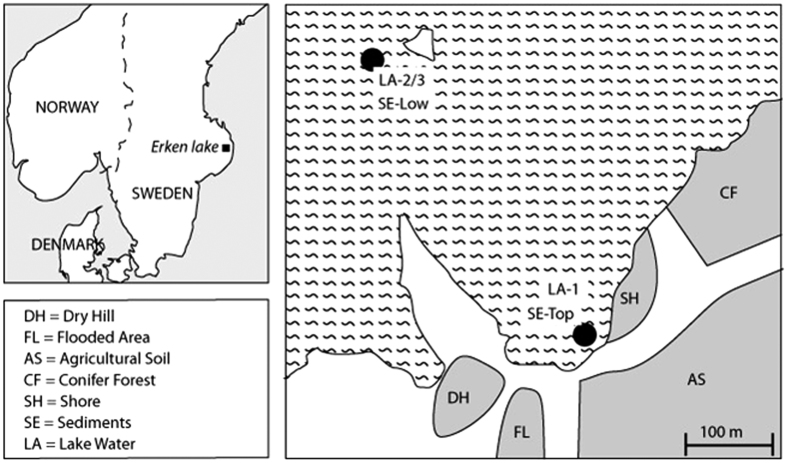
Location and description of sampling sites.The figure was composed using Adobe Illustrator CS3 software (www.adobe.com) based on Google Earth (Map data: Google, DigitalGlobe).